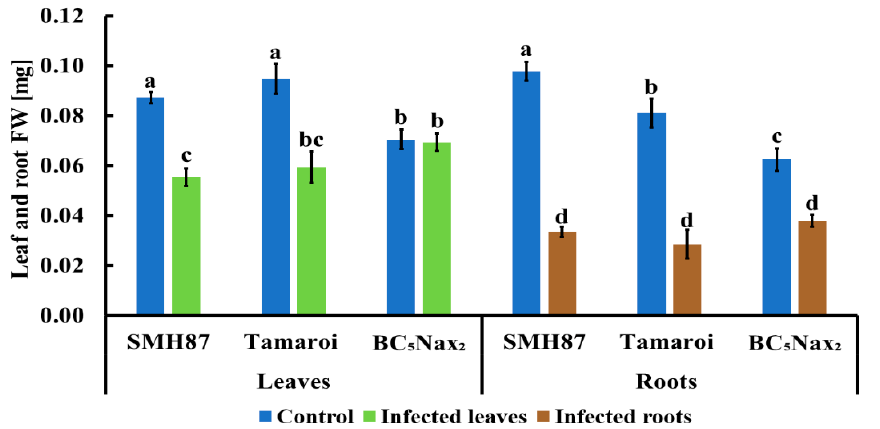
Figure 3 . Effects of F. culmorum infection on fresh weight (FW) of the leaves and roots of three durum wheat accessions. The values represent means ( n = 30) ± SE. Different superscript letters (a–d) for each organ indicate significant differences between means (Duncan’s multiple range test; p < 0.05).